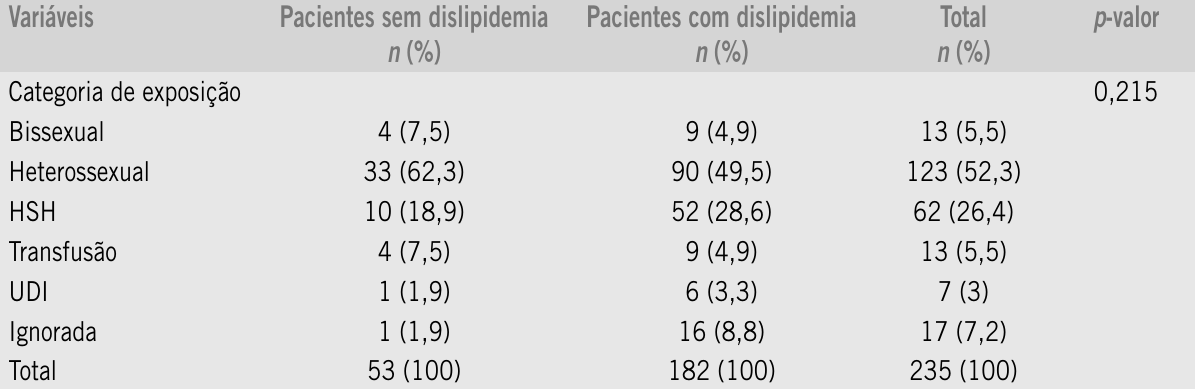
A Tabela 9 apresenta as estimativas da regressão de Poisson para as variáveis que permaneceram no modelo.